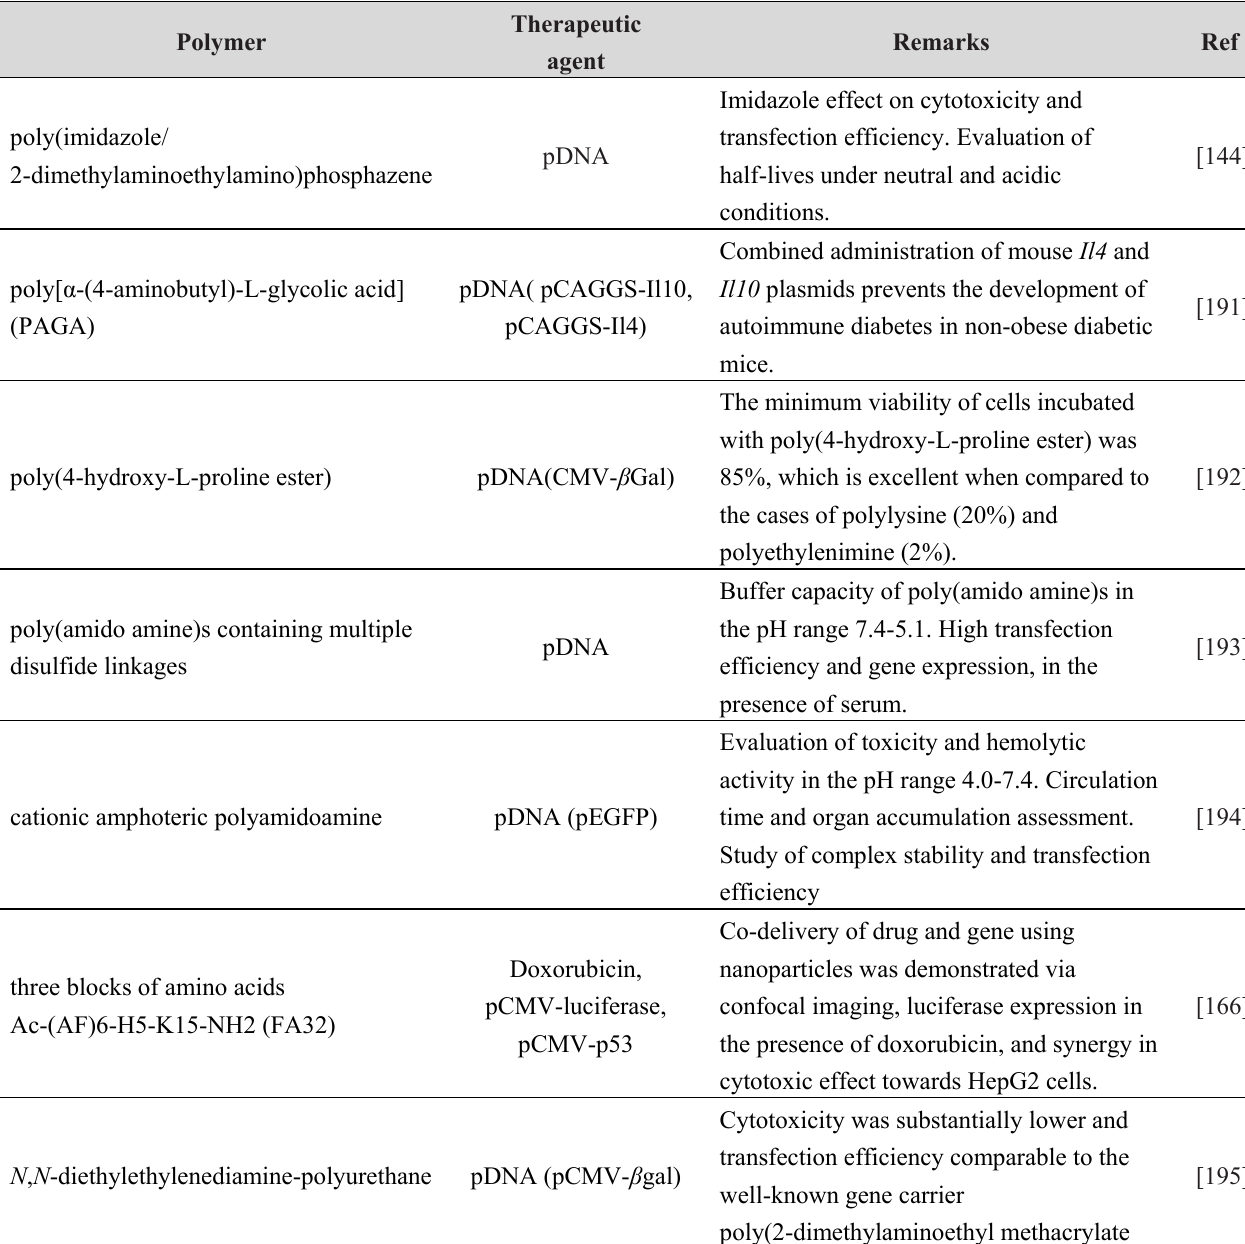
Table 5. Other synthetic polymers for gene